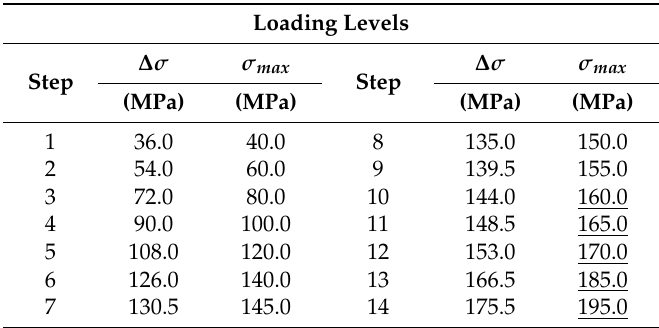
Table 2. Loading levels for self-heating tests.